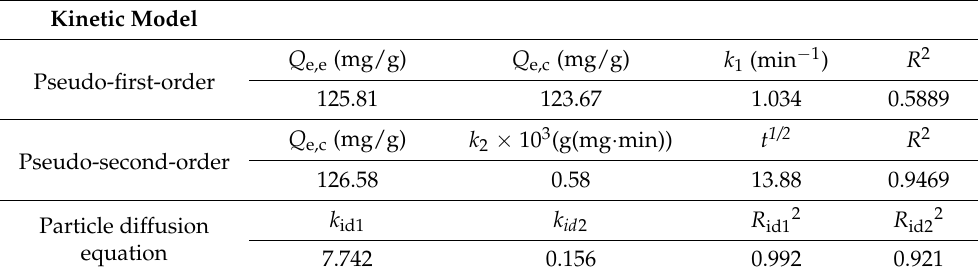
Table 1. Linear and nonlinear kinetic model parameters obtained in adsorption of 3,4,5-TCP onto